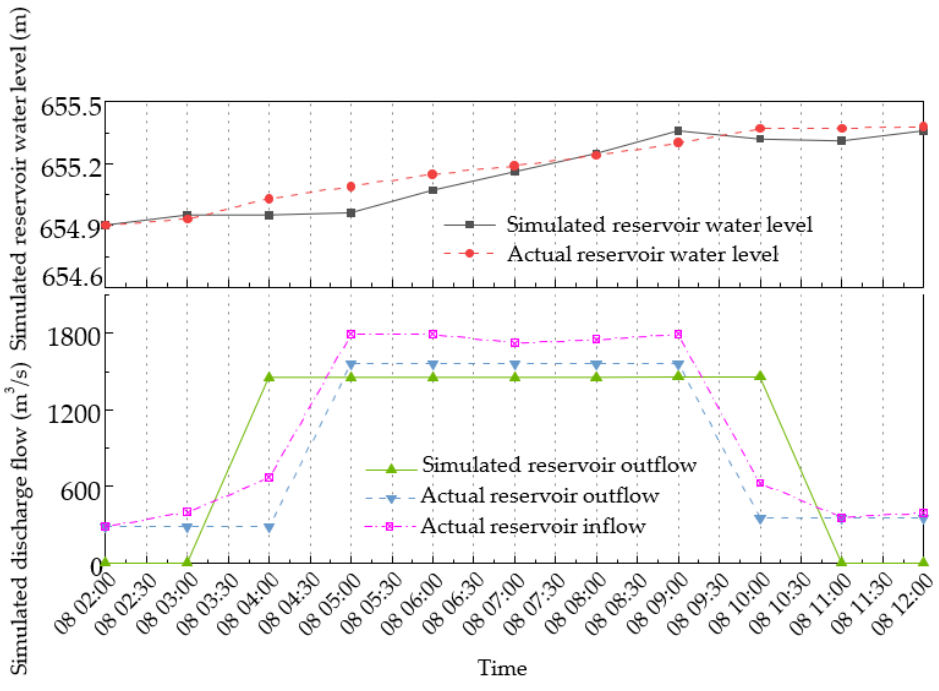
Figure 7. Comparison of water level and outflow discharge between simulated results and actual process under Condition B3.